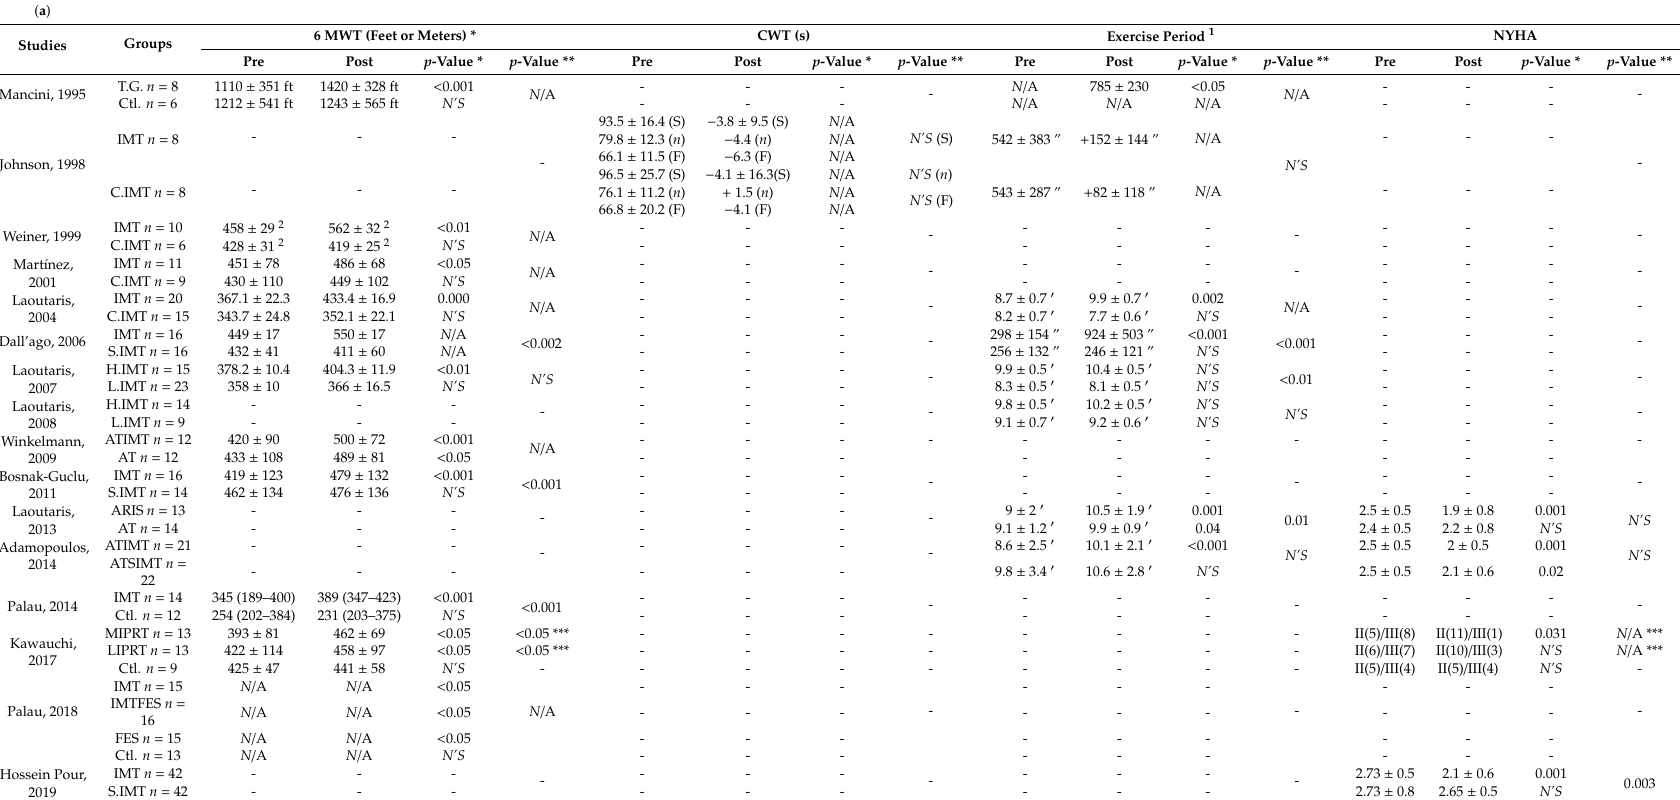
Table 4. a. Functional class and capacity; b. Strength in